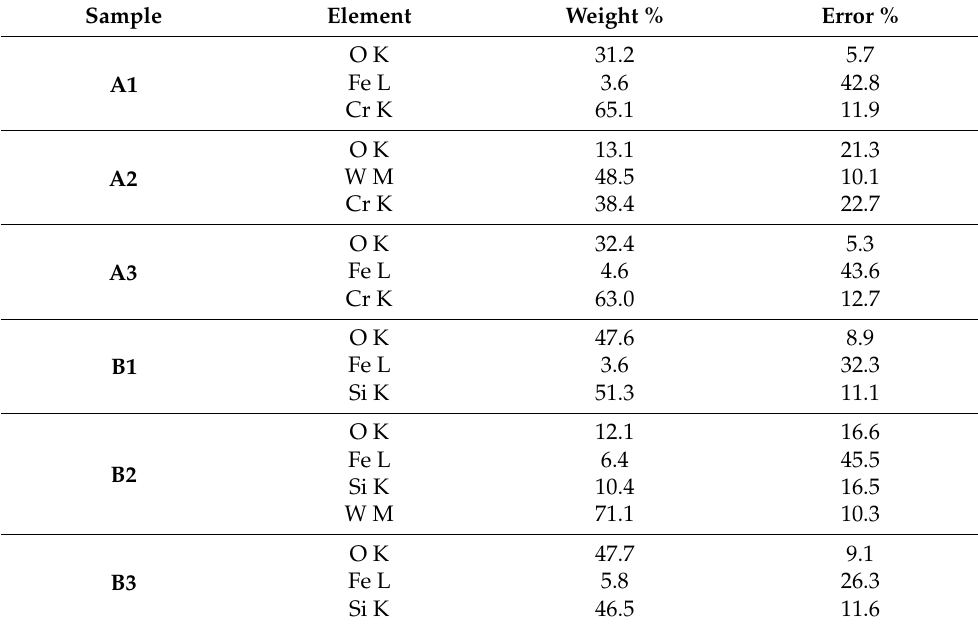
Table 2. EDX composition measurements